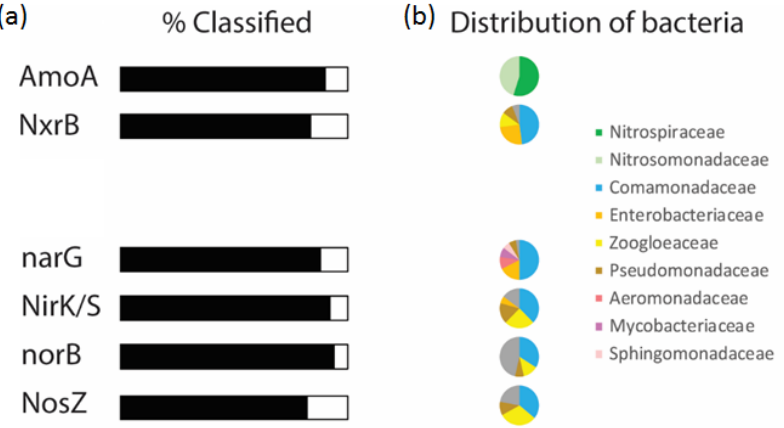
Figure A3. Percentage of classified ( white ) and unclassified ( black ) reads out of all the reads of each gene ( a ) and the composition of the identified genus of each gene ( b ).